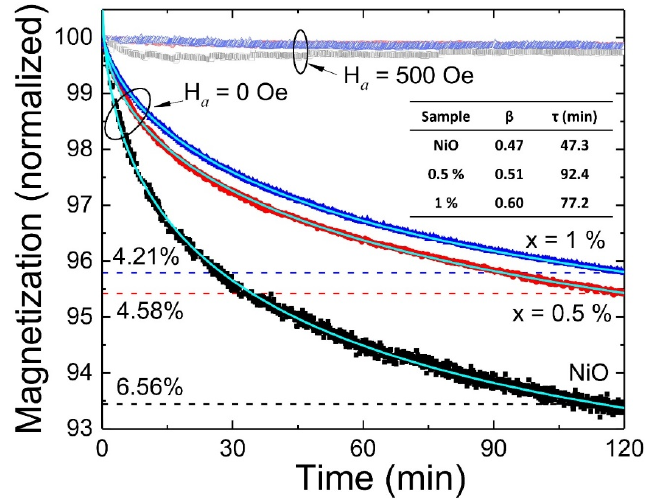
Figure 5. A plot of normalized magnetic moment relaxation measured concerning time M(t) at 300 K for 2 h from NiO (black), 0.5% (Red) and 1% (blue) samples in an applied field H a = 500 Oe (light color) and 0 Oe (dark color). The solid line represents a satisfactory linear fit to M(t) curves measured in 0 Oe using stretched exponential function with fitted parameters, as depicted in the inset. The horizontal dashed lines correspond to the amount of relaxation for 2 h in zero applied field for each composition.